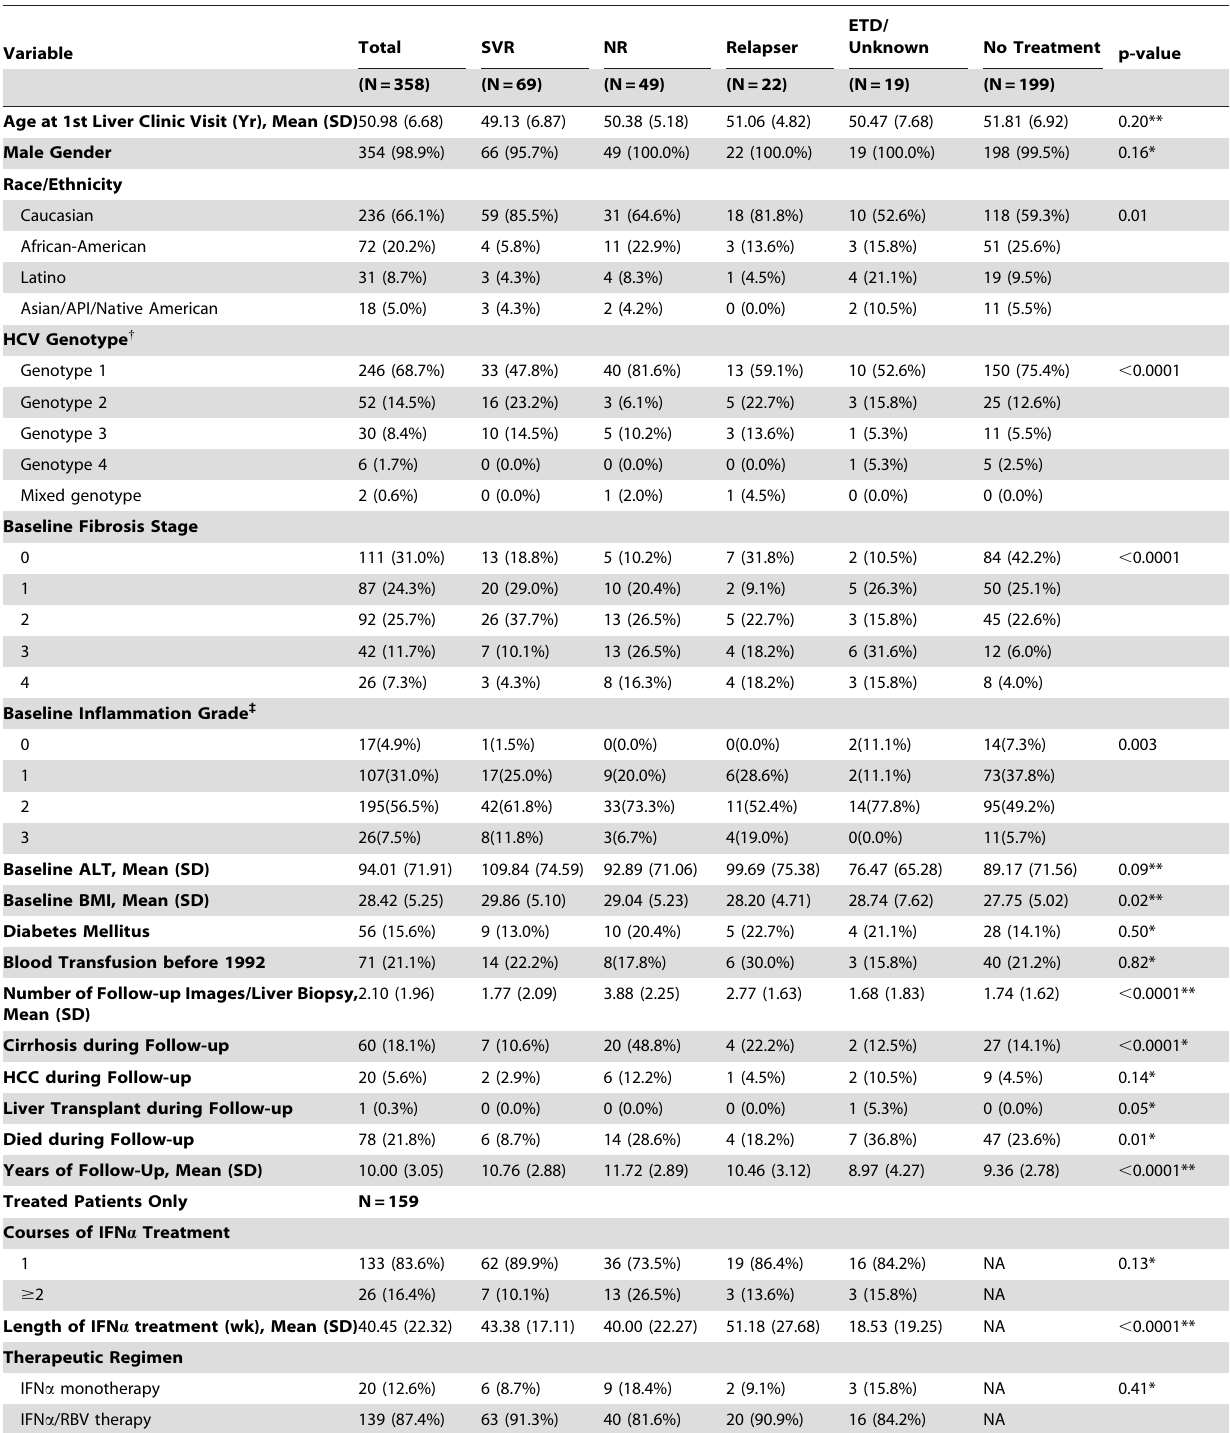
P-values were calculated from Chi-square test for category variables and ANOVA for continuous variables unless otherwise marked. *P-values were calculated from Fisher’s Exact test. **Variable was rank transformed. { 22 cases missing HCV genotype data.